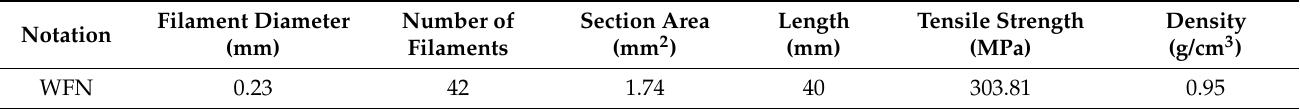
Figure 2. Tensile testing result of the WFN fibers. Table 1. Properties of waste fishing net (WFN) fibers.